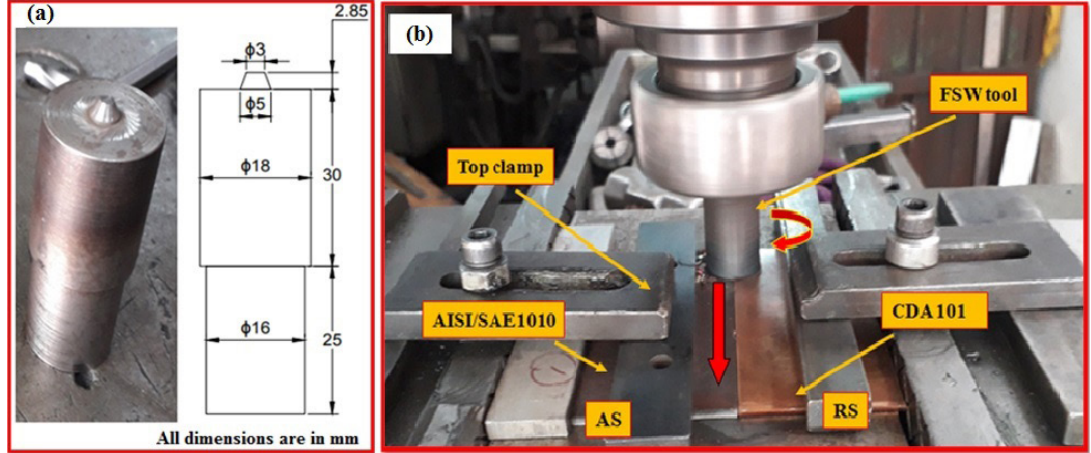
Figure 2. (a) Tapered pin profiled tool. (b) The FSW process and material arrangement setup.